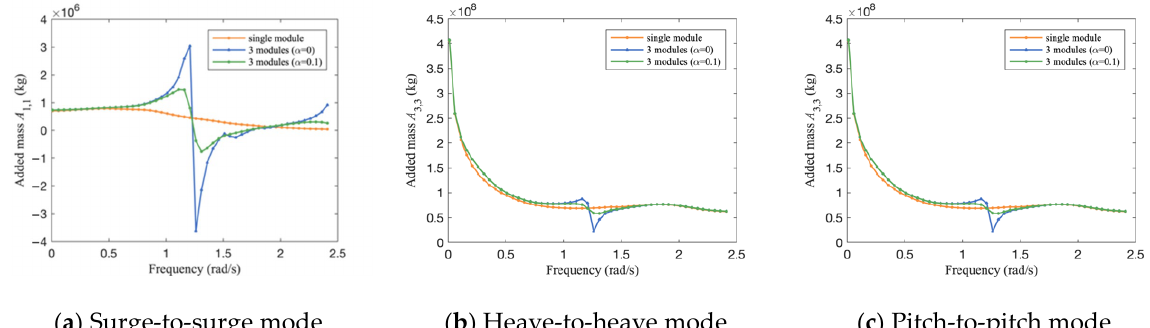
Figure 5. Comparison of the added mass coefficients.